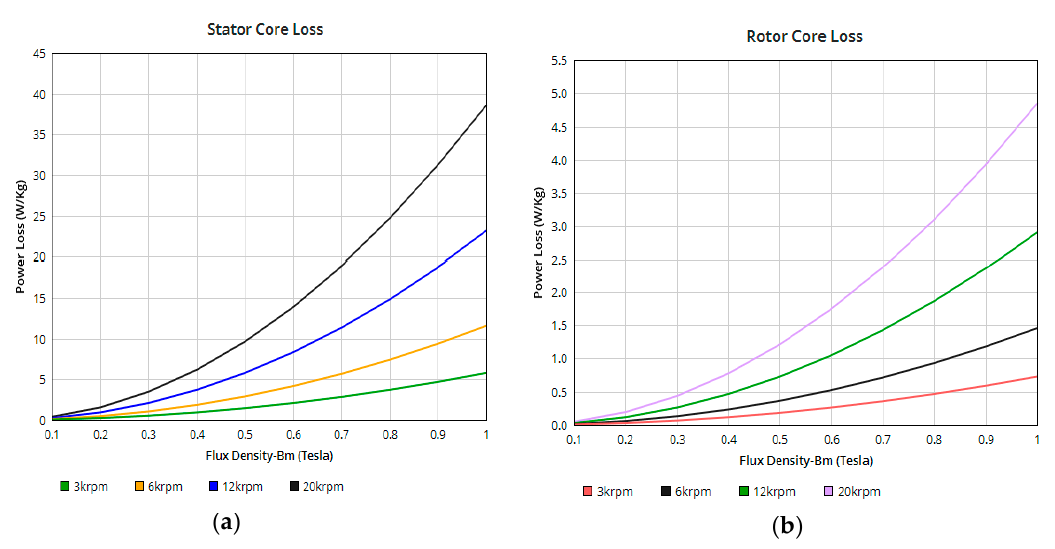
Figure 13. Different mechanical losses of SCIM-FESS: ( a ) Bearing losses due to load and speed torque; ( b ) Stray losses due to magnetic flux leakages; ( c ) Windage losses at low and high pressures;( d ) Total mechanical losses.